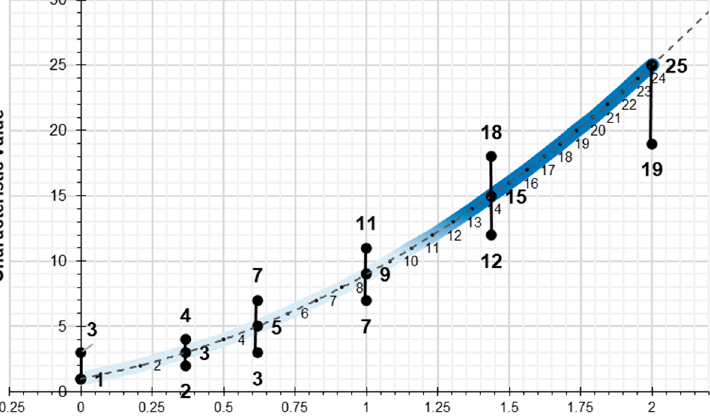
Figure 11. Variation in maximum and minimum for each characteristic value.